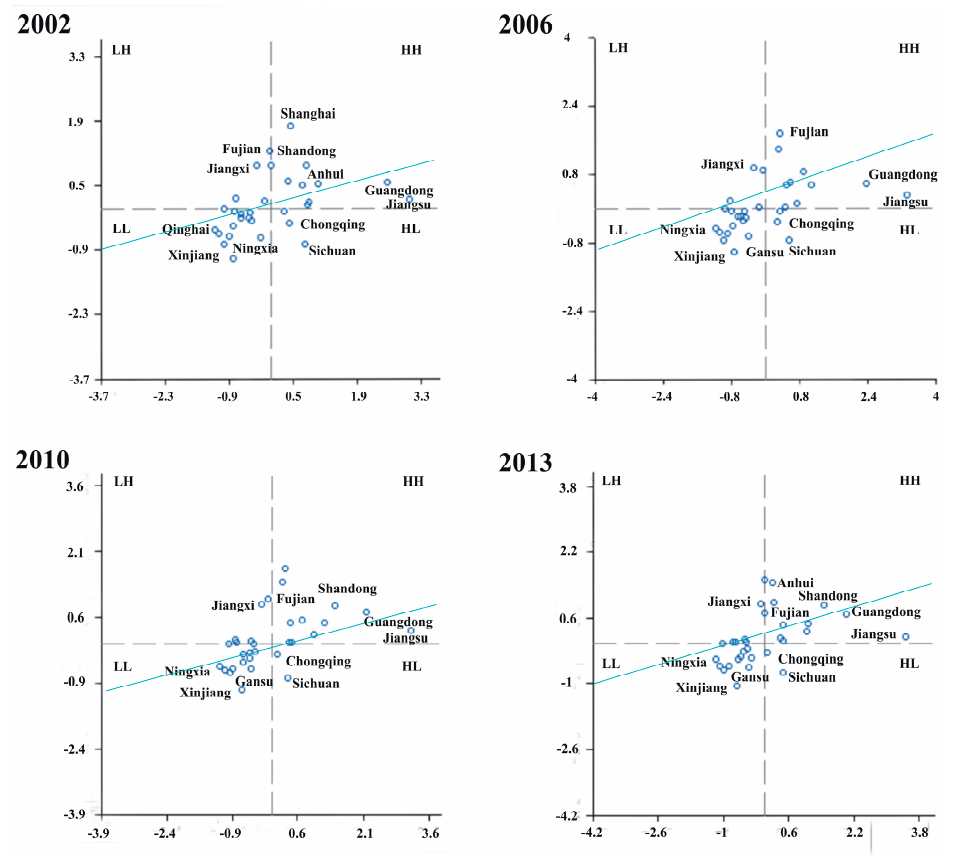
Figure 4. Moran scatter diagram of the provincial wastewater discharge in China, 2002–2013.